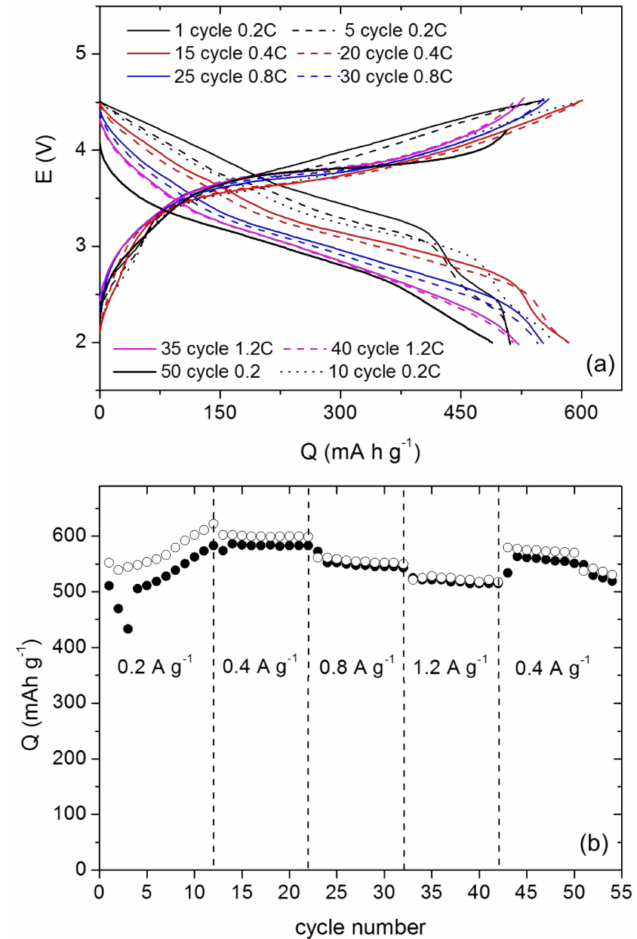
Figure 6. ( a ) Discharge-charge curves and ( b ) rate capability of the FO/LNM full cell at various current densities (LNM refers to LiNi 0.5 Mn 1.5 O 4